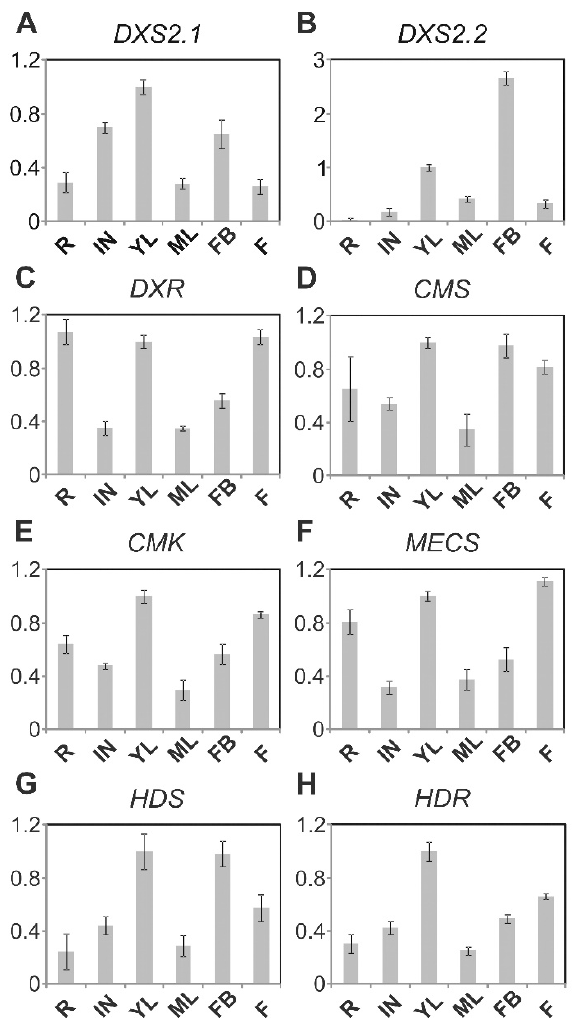
Figure 3. Expressing pattern of MEP pathway genes in different C. roseus organs. Total RNA was extracted from the root (R), young leaves (YL), mature leaves (ML), first internodes (IN), flower buds (FB) and mature flower (F), and subjected to reverse transcription. Transcript levels for MEP pathway genes and RPS9 were determined by real-time PCR using gene-specific primers. MEP pathway gene expression levels were normalized using RPS9 . The transcript level of young leaves was individually set to “1” for the eight genes. ( A ) DXS2.1; ( B ) DXS2.2; ( C ) DXR; ( D ) CMS; ( E ) CMK; ( F ) MECS; ( G ) HDS; ( H ) HDR.